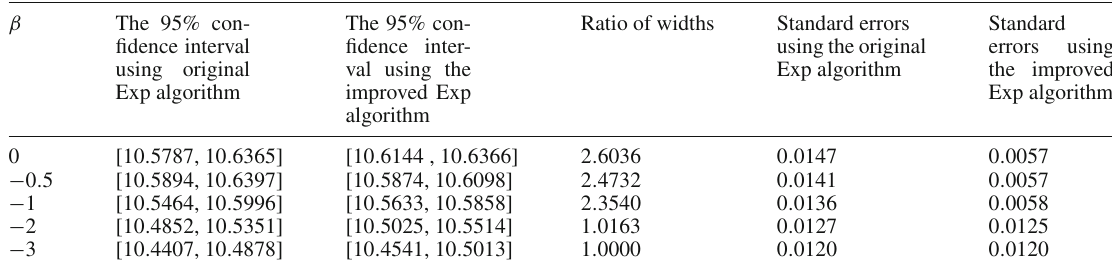
Table 6 95% confidence interval for the down-and-out call barrier option under the CEV model with M = 10 6 , σ = 0 . 25 and (cid:7) t = E [ δ t ] = 0 . 002 β The 95% con- fidence